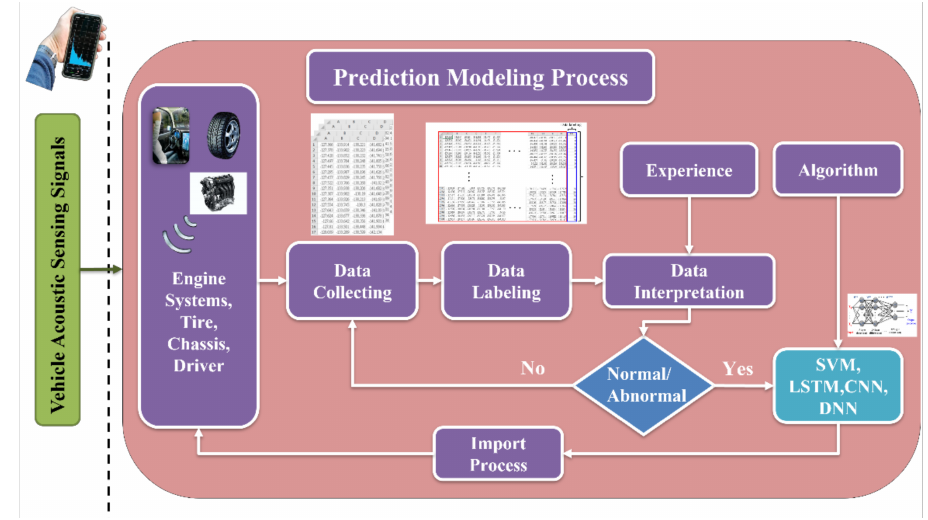
Figure 7. Malfunction acoustic diagnosis prediction modeling process.